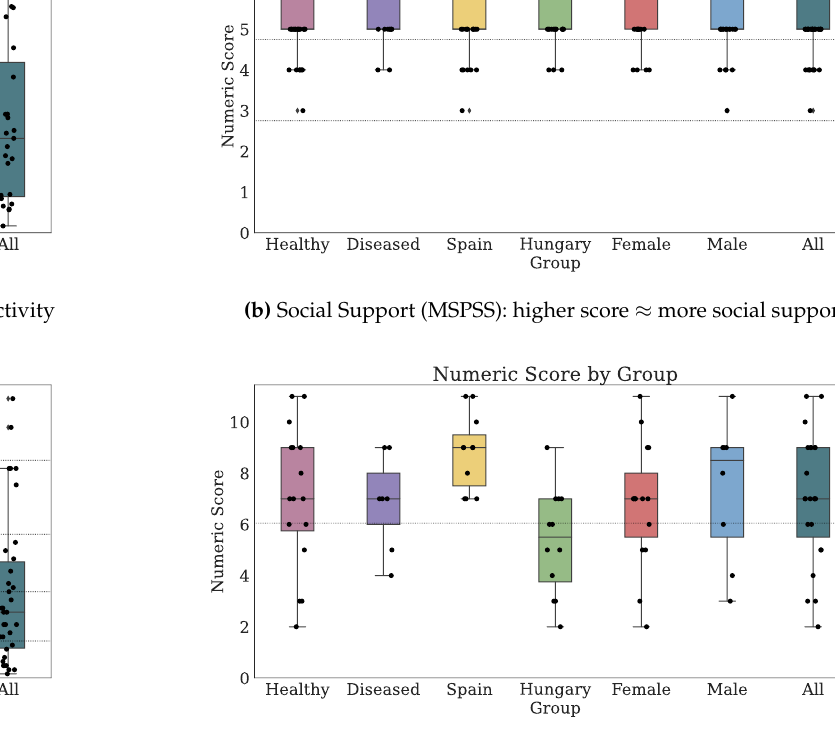
Figure 2. Numeric scores for Physical Activity, Social Support, Anxiety and Depression, and Mediterranean Nutrition. Dotted markings delimit levels of the categorical score, where available (1 of 2)